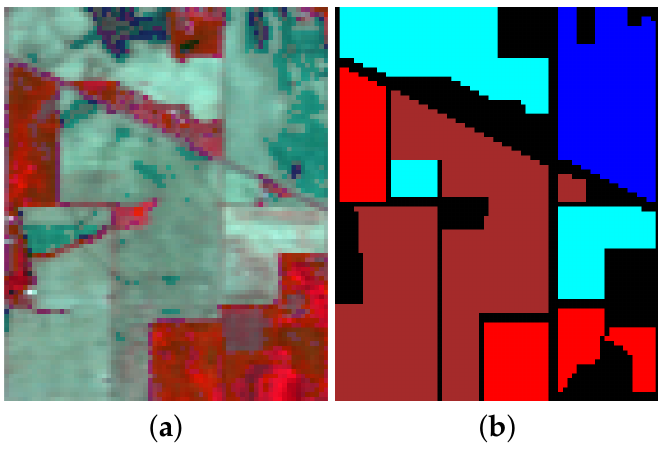
Figure 3. The false color image ( a ) and the corresponding ground truth ( b ) of the tested Indian Pines